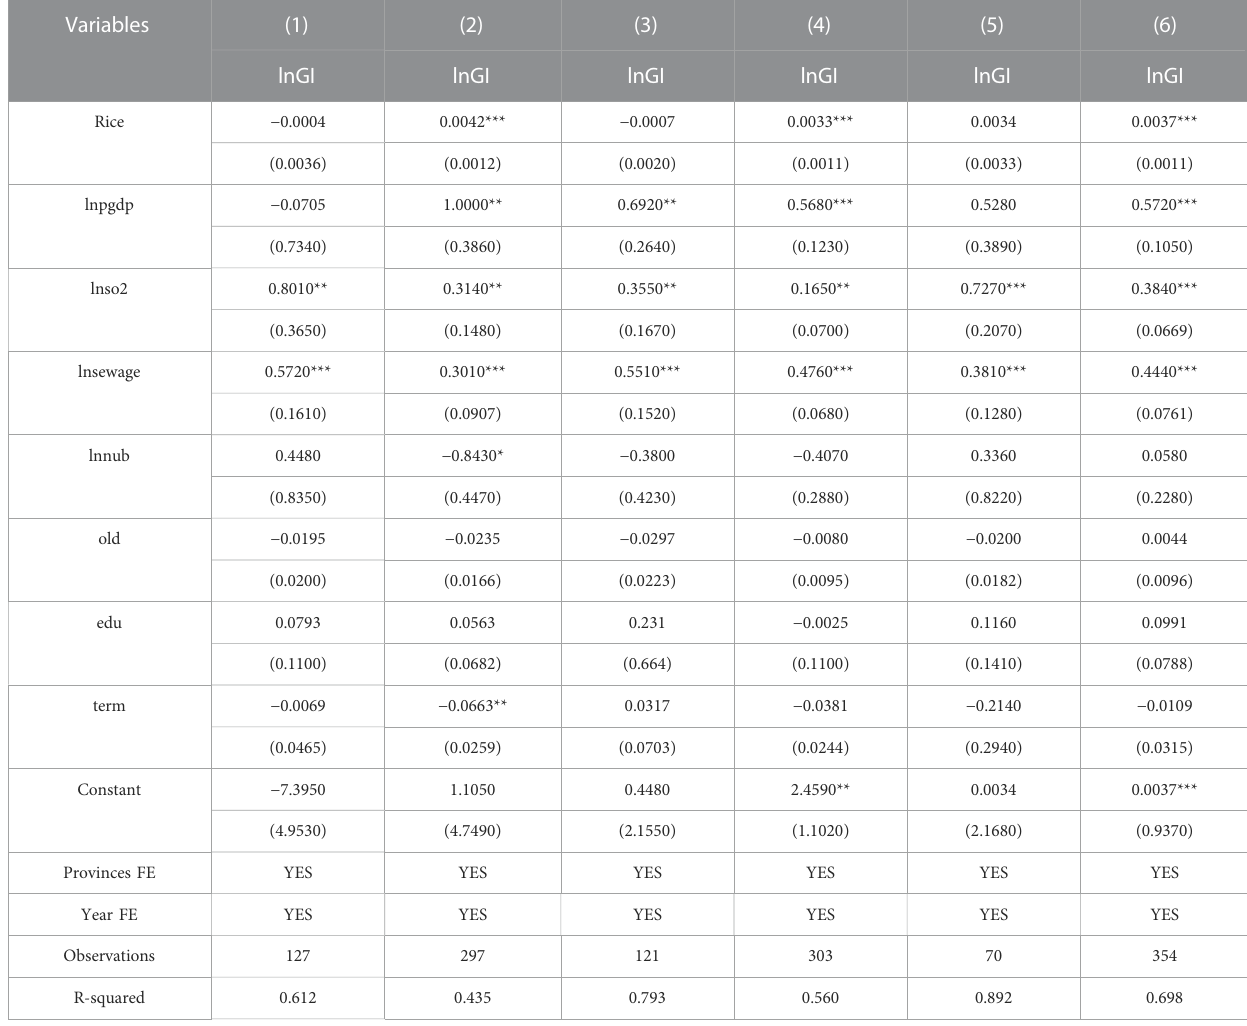
TABLE 4 Heterogeneity analysis of governors ’